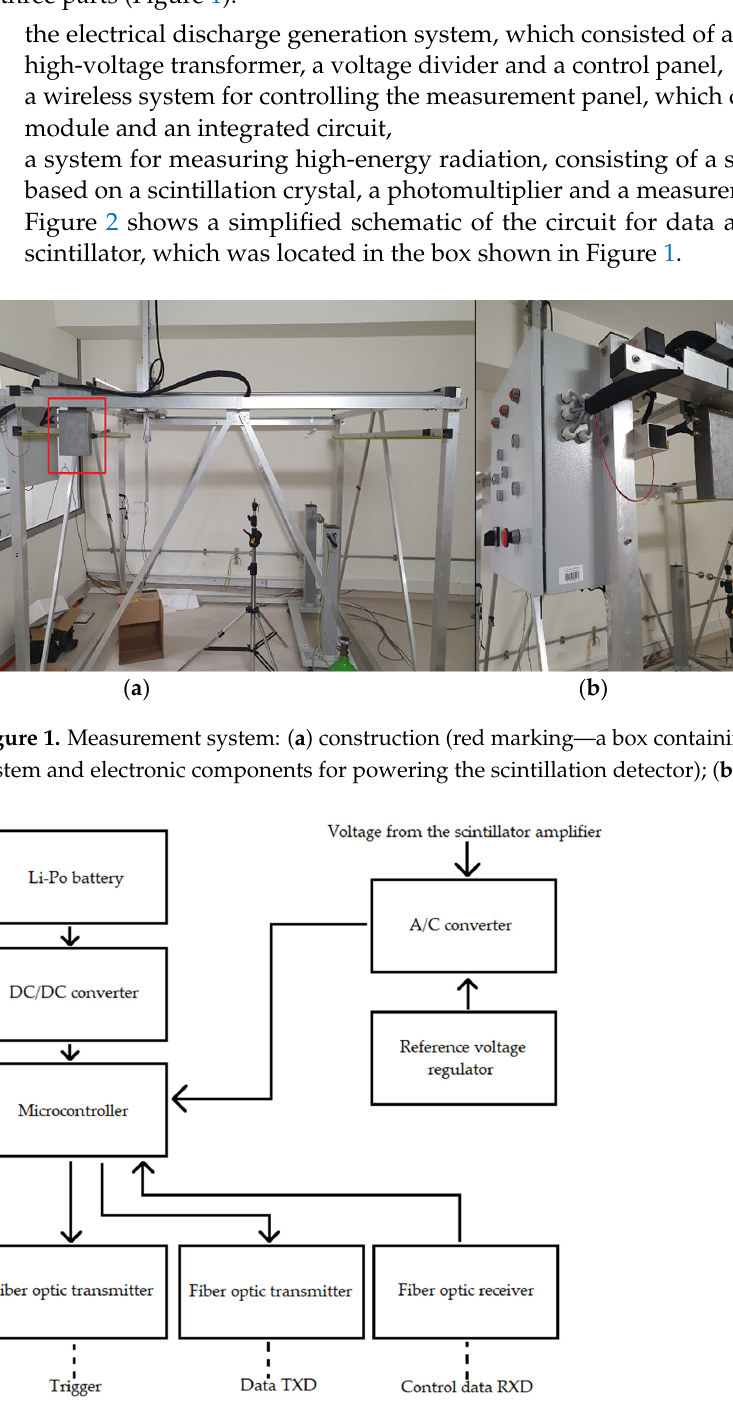
Figure 2. Simplified block diagram of a fiber optic system for scintillator data acquisition.